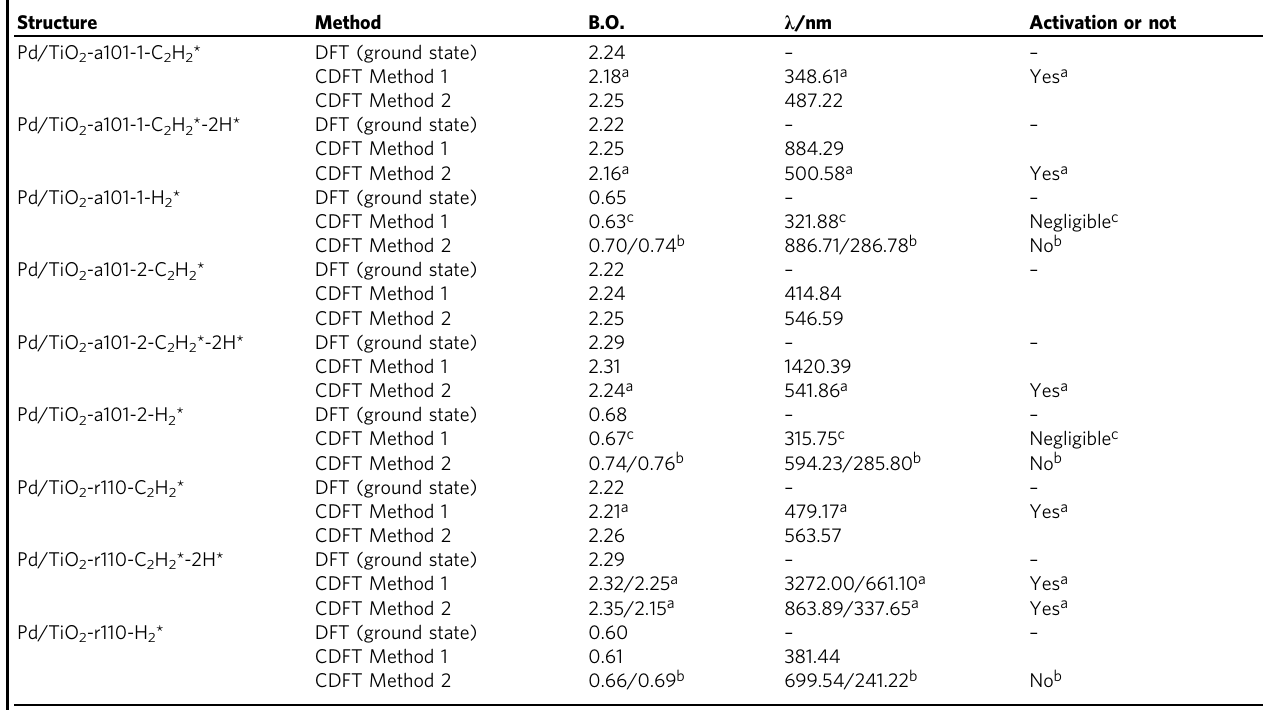
Table 1 Bond orders of states and energy differences between charge-transfer states and their corresponding ground states in wavelength